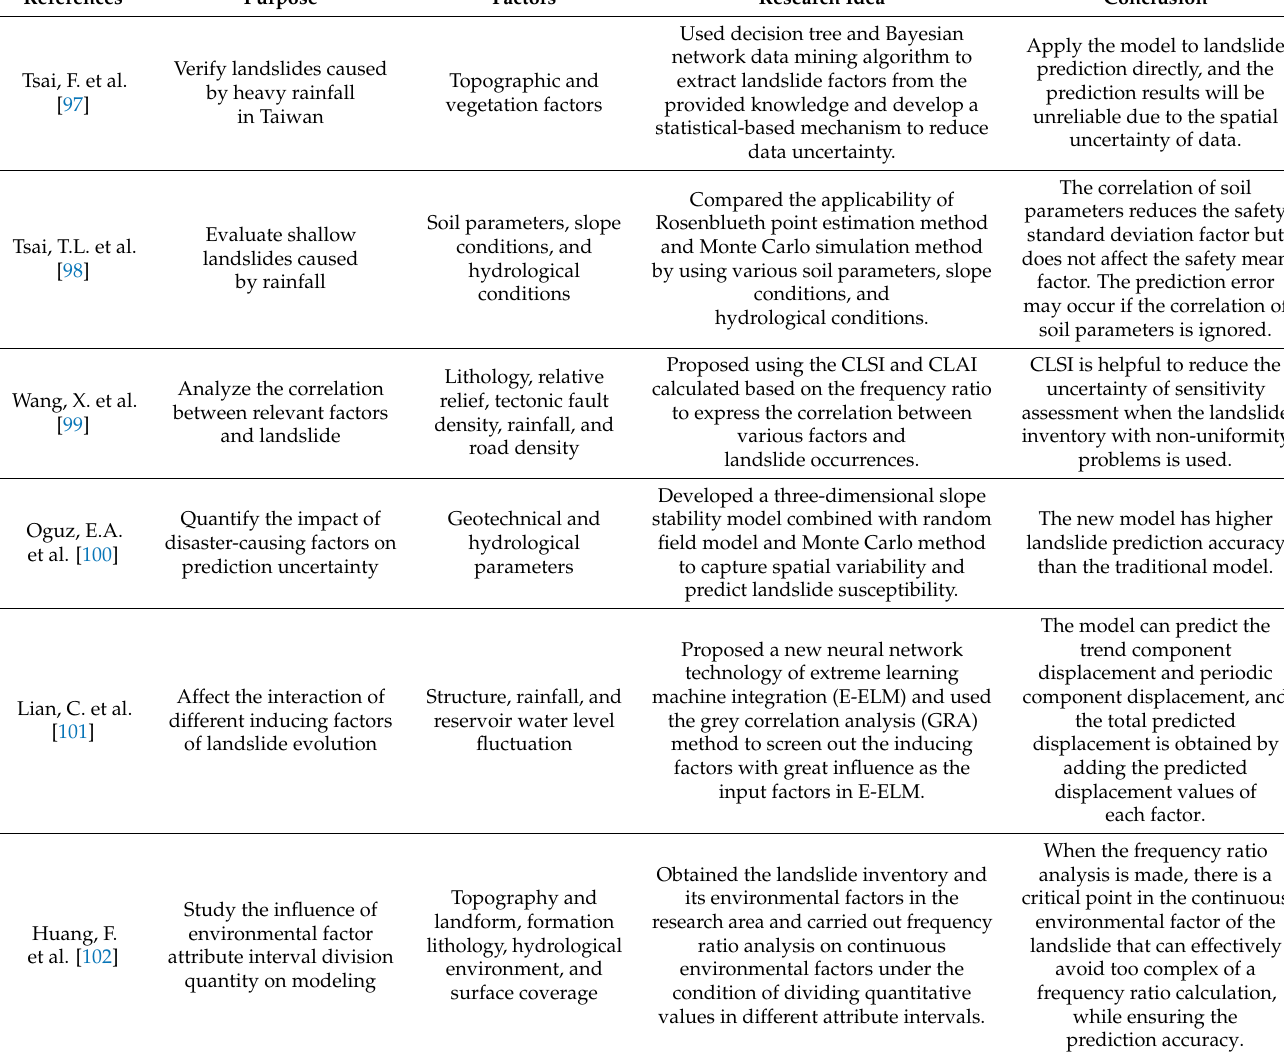
Table 4. Typical cases of nonlinear correlation analysis of disaster-causing